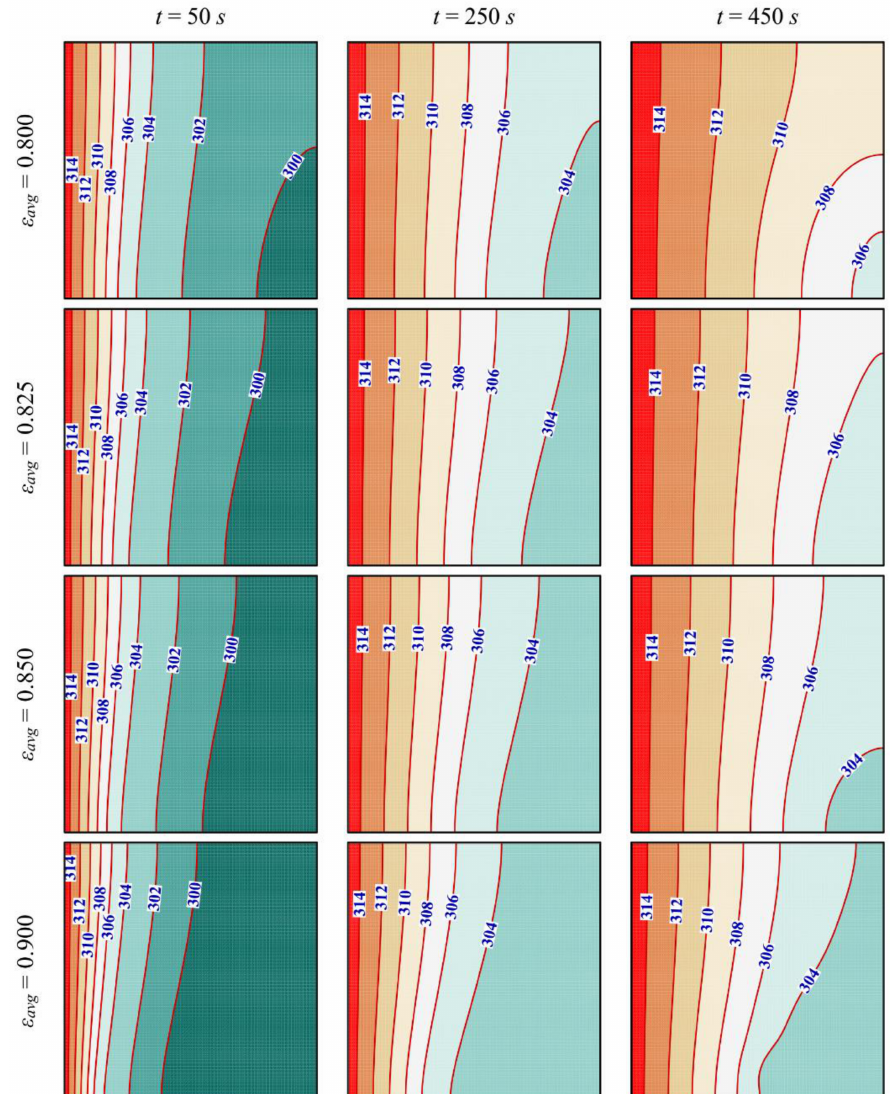
Figure 6. Isotherm contours at three different times for various average porosities when VF na = 0.01, a = − 2, γ = 2 π /4, and PPI =